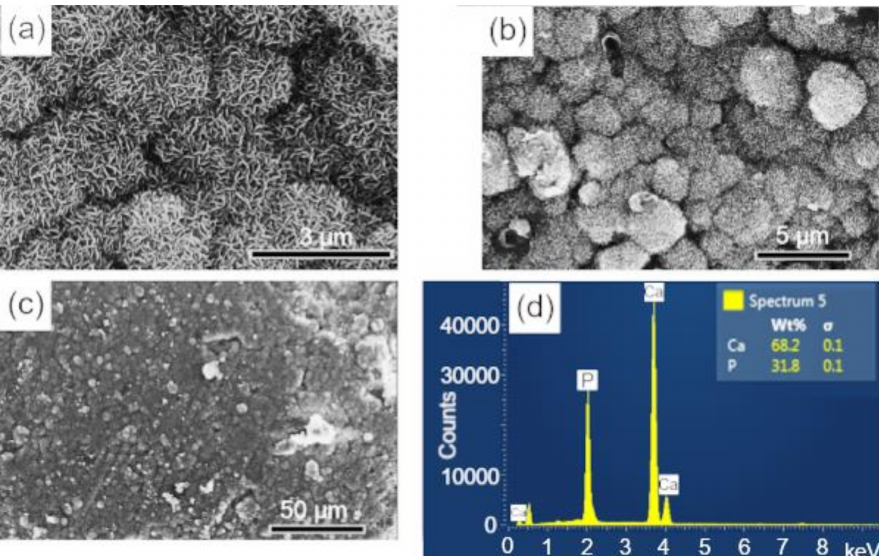
Figure 9. SEM imagens of the scaffold surface (BCP-CL) after 28 d of immersion in SBF, showing a characteristic morphology of apatite nucleation in bioactive materials: ( a – c ) images with differ- ent magnifications and ( d ) EDS obtained on the sample surface. Ca = calcium; P = phosphorus; %wt = mass fraction; σ = mean deviation.